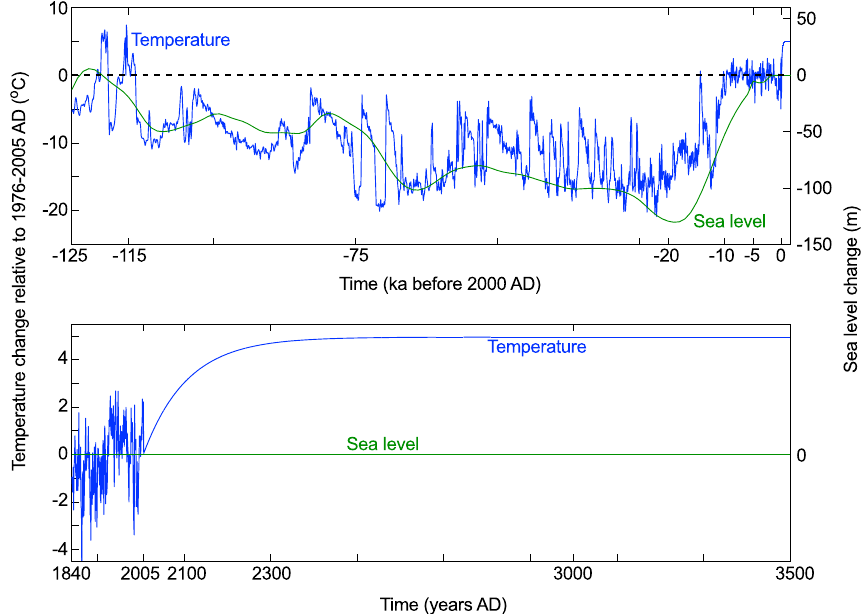
Fig. 2. Surface temperature (blue) and background sea level (green) curves used to drive the ice sheet model simulations. Top panel: full extent of runs ( − 125ka to 3500 AD; 2000 AD is indicated by 0); bottom panel: 1840 AD to 3500 AD. Temperature and sea level curves for − 125ka through 1840 AD come from the seaRISE project (http://websrv.cs.umt.edu/isis/index.php/SeaRISE Assessment; seaRISE partners, 2008; Greve et al., 2011) and are based on oxygen isotopes in ocean sediment cores (Imbrie et al., 1984) and in central-Greenland ice cores (Dansgaard et al., 1993; Johnsen et al., 1997). 1840–2005 AD temperatures come from southwestern Greenland observations (Vinther et al., 2006). Future temperatures assume an asymptotic increase to ∼ 5 degrees C above 1976–2005 levels, with a time scale of 100yr (Greve, 2000; see text). Background sea level is held constant from 1840–3500 AD. Labeled tick marks are those referred to in the text and figures; unlabeled tick marks are 25ka apart in the top panel and 200yr apart in the lower